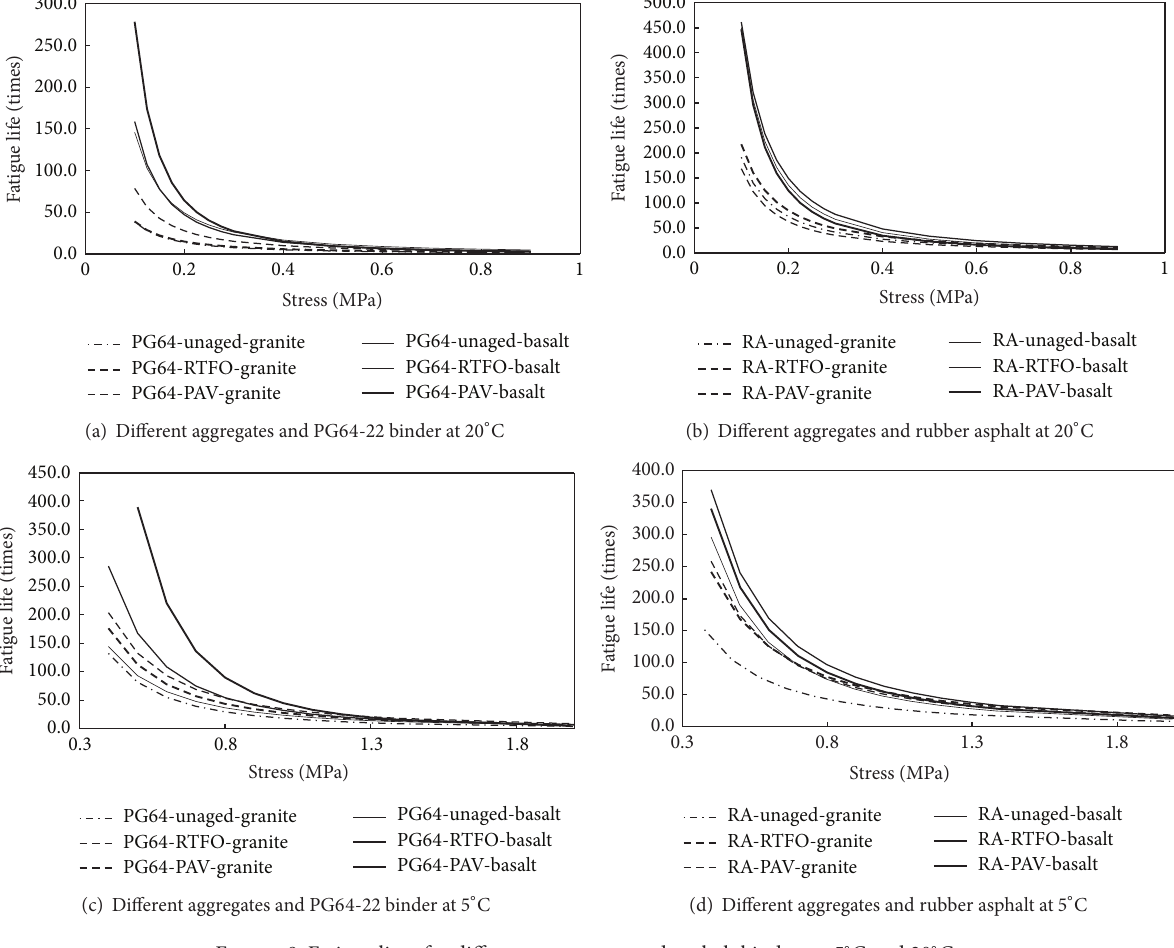
Figure 8: Fatigue lives for different aggregates and asphalt binders at 5 ∘ C and 20 ∘ C.